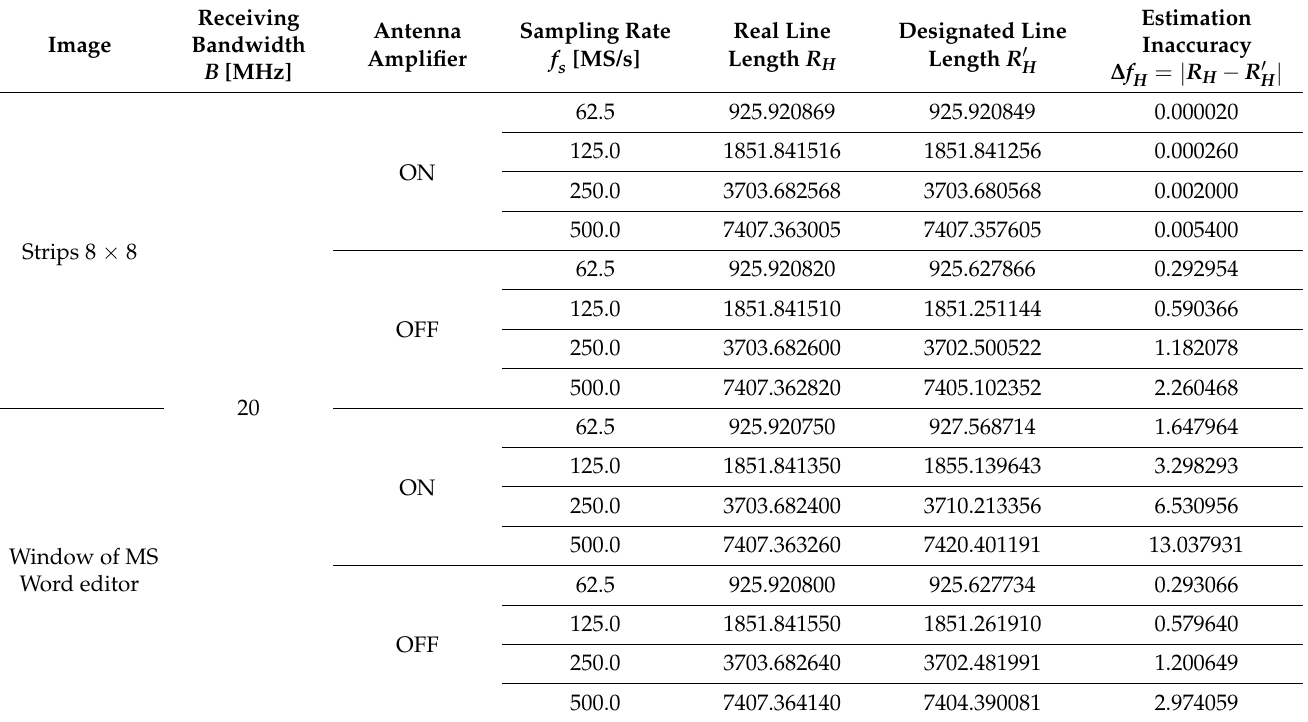
Table 9. Determination of the R H parameter for the reception frequency f o = 102 MHz, in the receiving band BW = 20 MHz, with the antenna amplifier on and off (+ 10 dB ) .